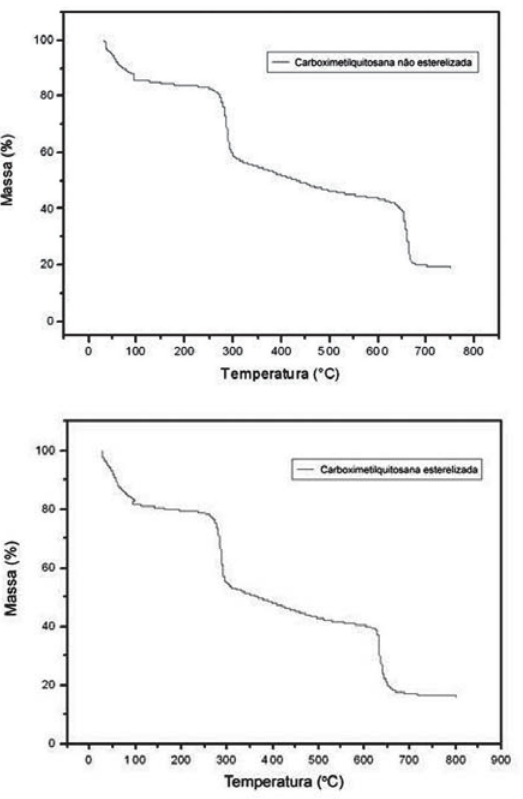
Fig. 1 – Valores e curvas obtidos pela análise